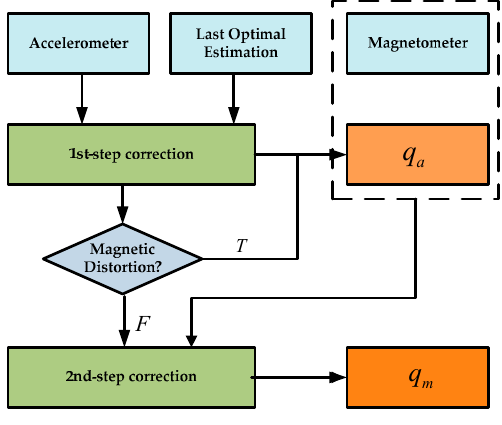
Figure 2. Block diagram of the TGIC.